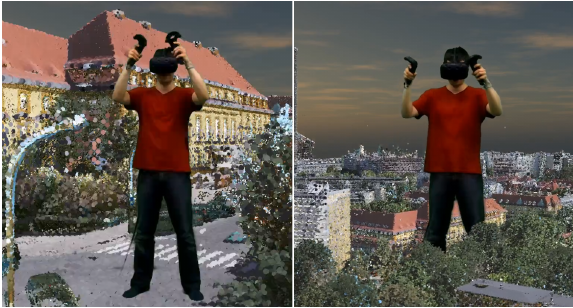
Figure 4. A gesture-based transformation tool allows to scale, translate and rotate 3D point clouds